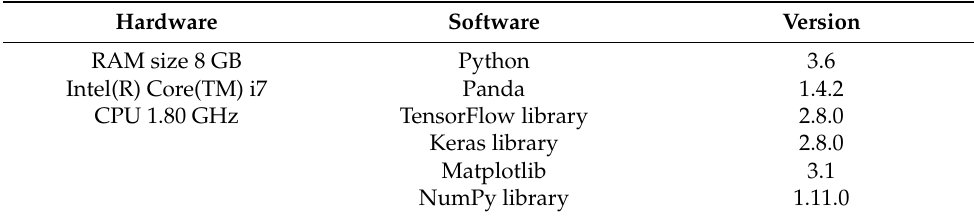
Table 5. Environmental requirements of the proposed